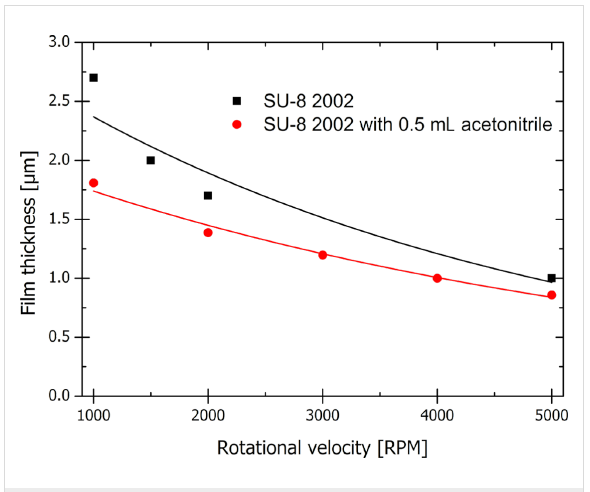
Figure 1: Spin curves for SU-8 2002 and SU-8 2002 with acetonitrile. The addition of acetonitrile results in a decreased film thickness compared to the unmodified